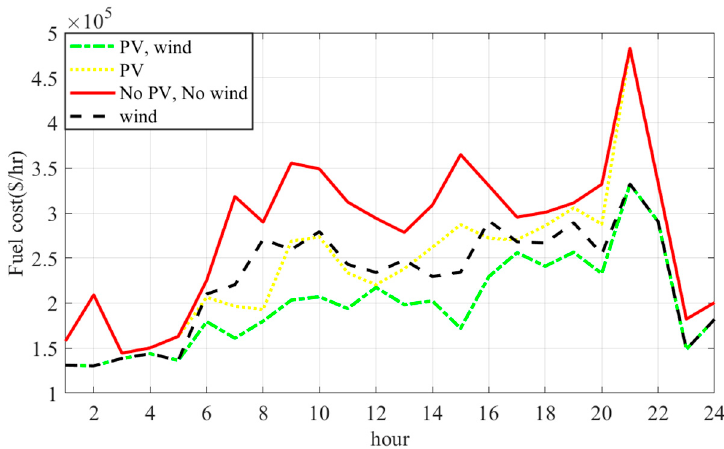
Figure 13. Cost variations of the 118-bus test network.